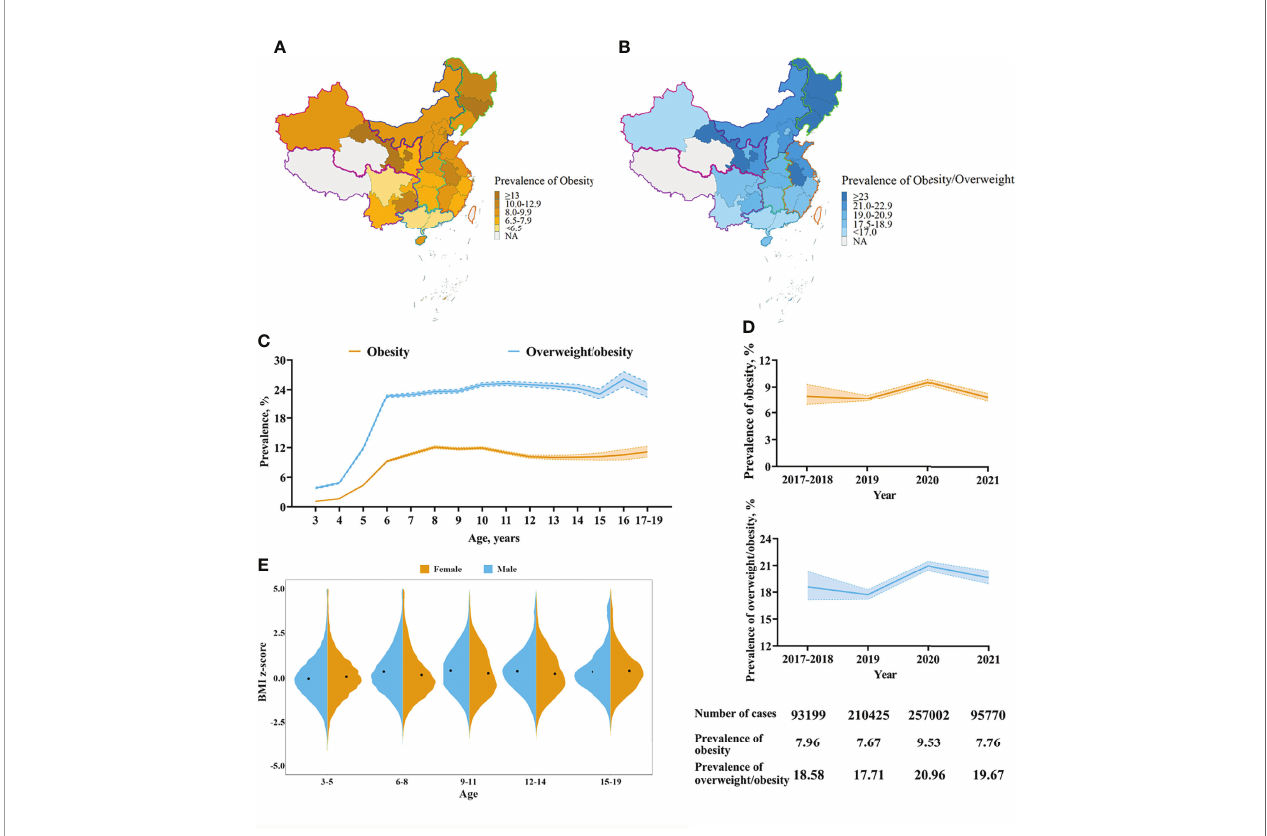
FIGURE 2 | Characteristics of the standardized prevalence of obesity and overweight and BMI z-score. (A) The standardized prevalence of obesity by province. (B) The standardized prevalence of obesity and overweight by province. The prevalence was standardized by sex and age in different provinces. This study didn ’ t included children in Taiwan, Hong Kong and Macao. Cases in Tibet Autonomous Region and Qinghai province were limited thus were not included in the map. (C) Trajectories of the prevalence of obesity and overweight by age. (D) Trends of the prevalence of obesity and overweight. The prevalence was standardized by sex and age. The band indicated 95% CI. (E) BMI z-score of different sexes and ages. Black points indicated the mean of BMI z-score of different groups.